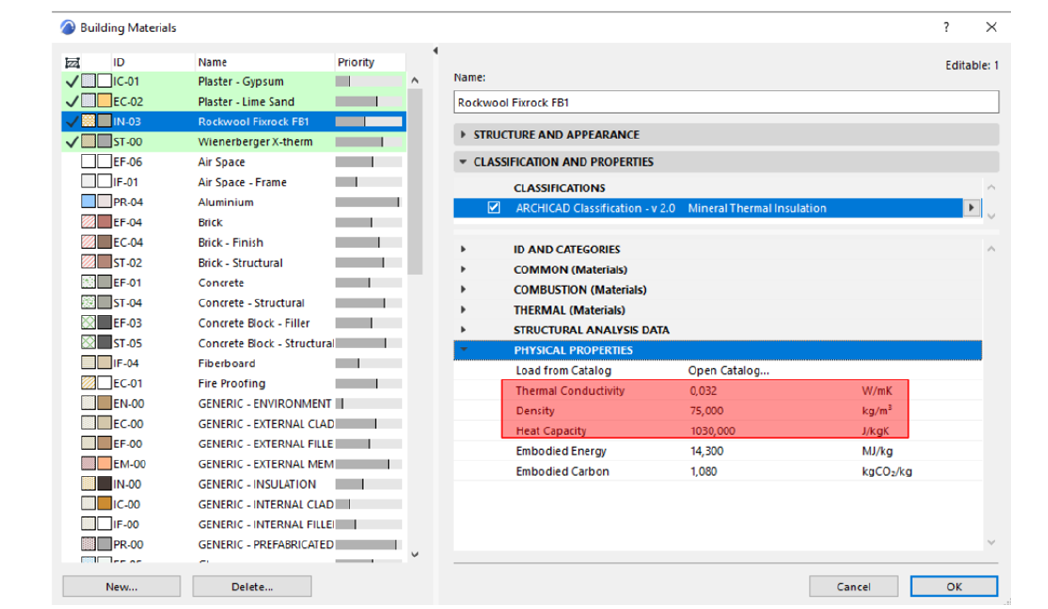
Figure 8. Building material catalogue in Archicad with the default available physical parameters.